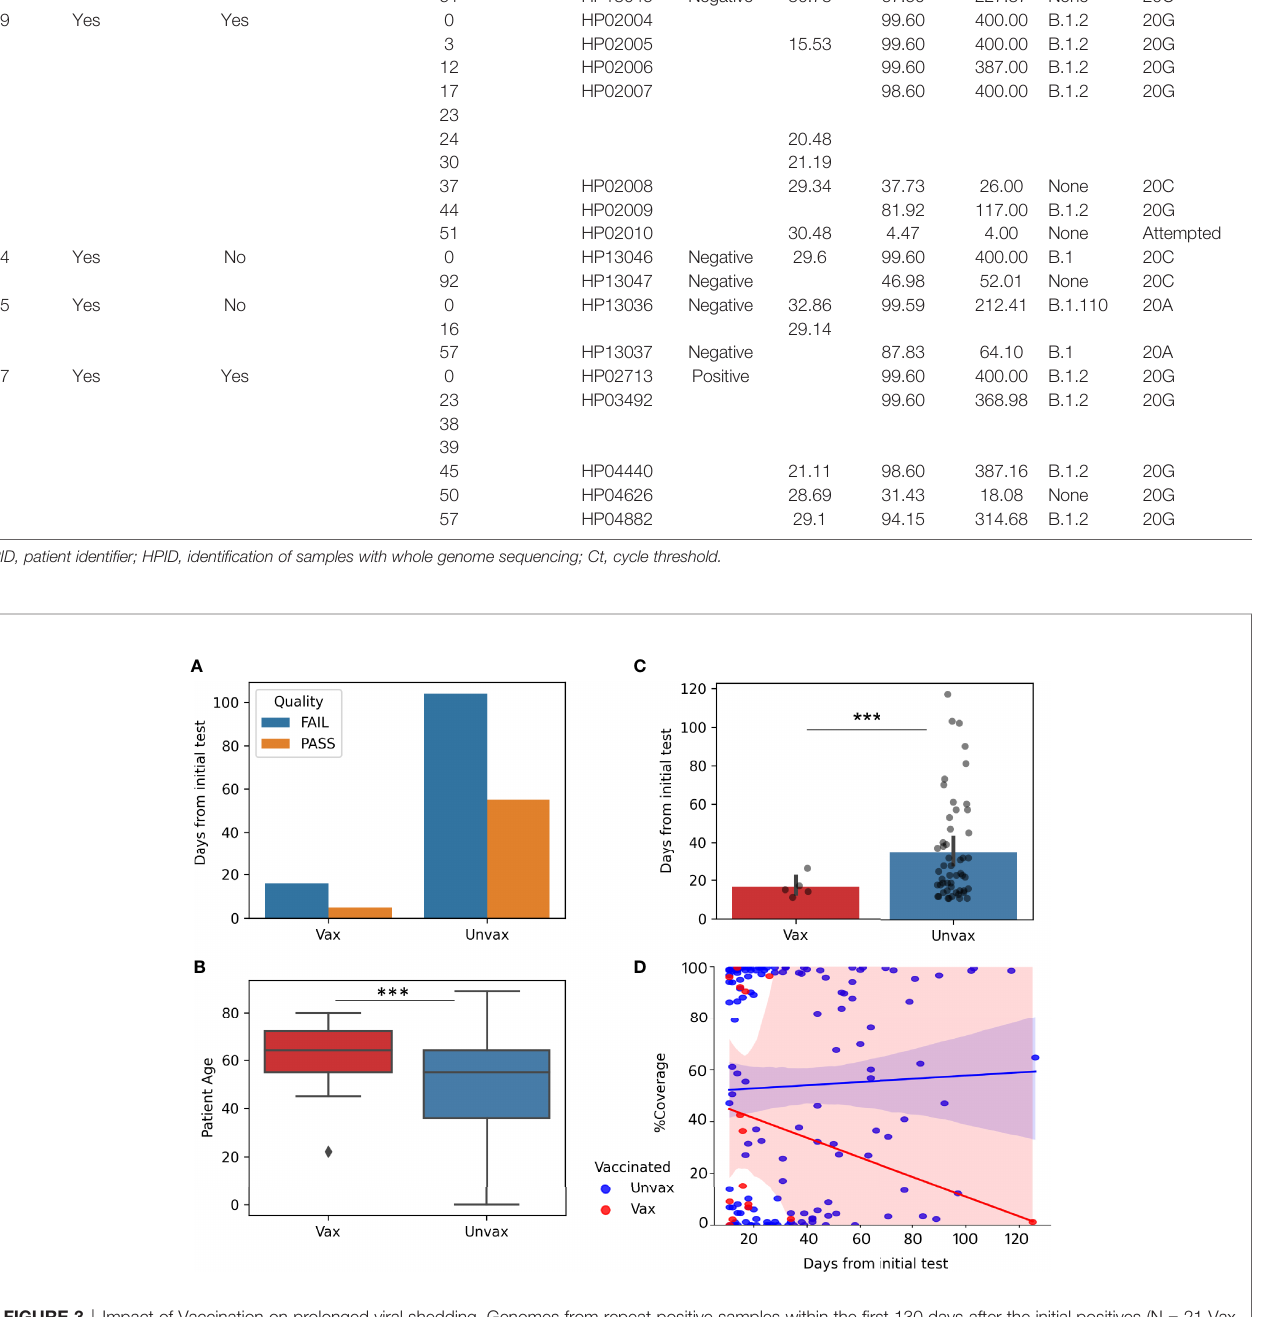
FIGURE 3 | Impact of Vaccination on prolonged viral shedding. Genomes from repeat positive samples within the fi rst 130 days after the initial positives (N = 21 Vax “ vaccinated ” and 159 Unvax “ unvaccinated ” ). (A) Quality of genomes in samples from vaccinated and unvaccinated patients. (B) Boxplot of Patient Age in samples from vaccinated (Median 64 years) and unvaccinated (median 55 years). (C) Barplots with overlayed strip plots of the recovery of high-quality genomes compared in relation to days after the fi rst positive. (D) Implots of genome coverage compared to days from the initial positive. ***p < 0.0001.